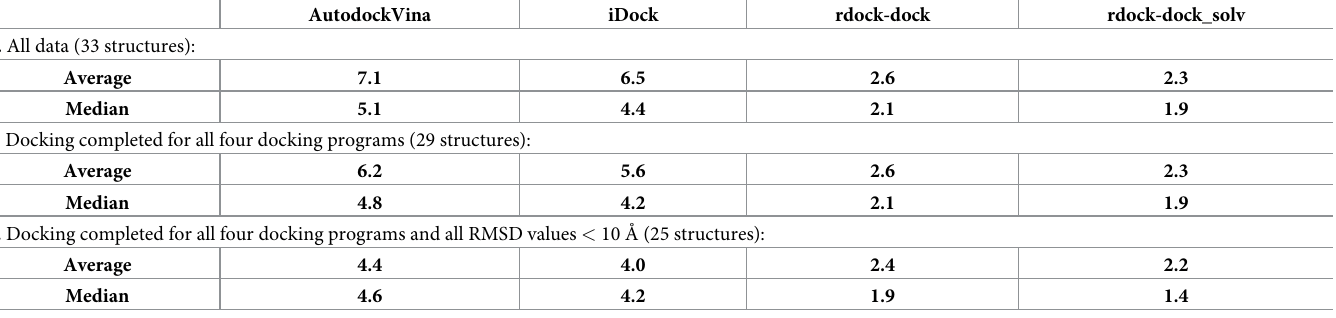
Table 2. Average and median values of the lowest RMSD reported for rDock (dock and dock_solv potentials), AutoDock Vina, and iDock. Values calculated for all structures in the testing set ( A ), only for structures for which all programs completed docking ( B ), and only for structures for which RMSD values of poses found by all pro- grams are below or equal 10 Å ( C ). Docking was performed using a native conformation of a ligand as an